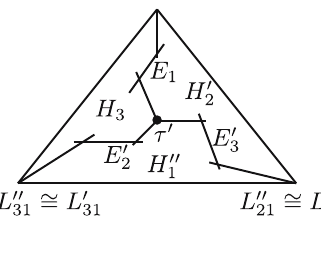
Figure 3: The SNC complex surface X